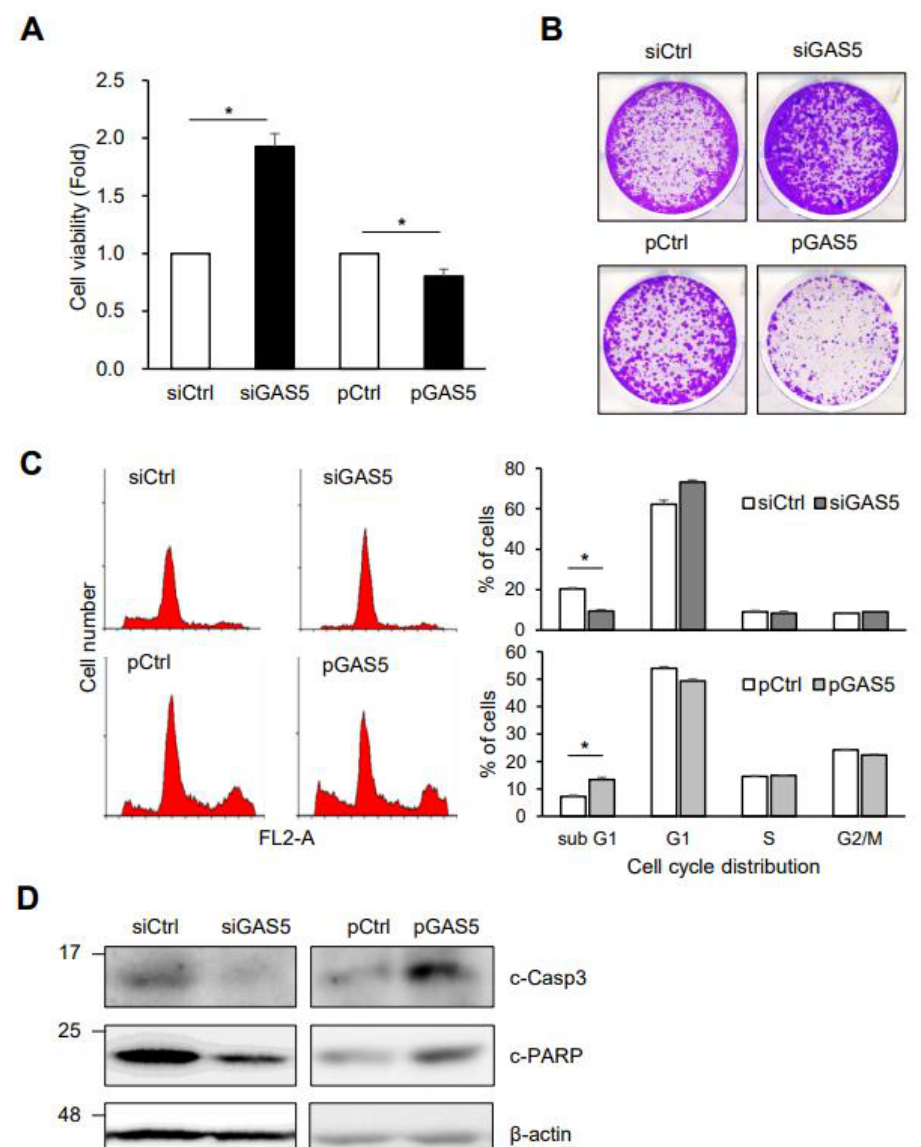
Figure 2. GAS5 promotes cell death in response to 5-FU. HCT116 cells were transfected with siRNAs or plasmids and further incubated with 5-FU. The effects of GAS5 on cell viability, growth, and death were assessed by MTT assay ( A ), colony-forming assay ( B ), flow cytometry ( C ), and western blotting analysis ( D ). Cell viability was determined by measuring the absorbance of the formazan crystals generated by cells. Colony-forming ability was assessed by counting the number of colonies after two weeks of incubation. Cells were stained with propidium iodide, and the distribution of the cell cycle and the cell populations in the sub-G1 phase were analyzed by flow cytometry. For measuring apoptotic cell death, the levels of cleaved caspase-3 (c-Casp3) and cleaved PARP (c-PARP) were determined by western blotting analysis. β -actin was used as a loading control. Data were expressed as the mean ± SEM, and images are representative of three independent experiments. The statistical significance of the data was analyzed via Student’s t -test; *, p < 0.05.